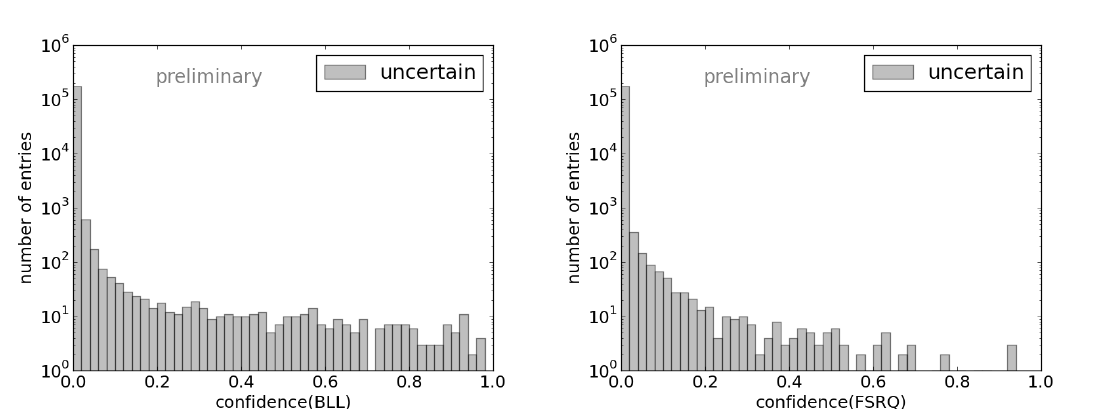
Figure 3. Confidence distribution for the BLL ( left ) and the FSRQ class ( right ). The classification model is applied to the data set of AGNs of uncertain type extracted from the 3FGL and the ALLWISE catalogs.